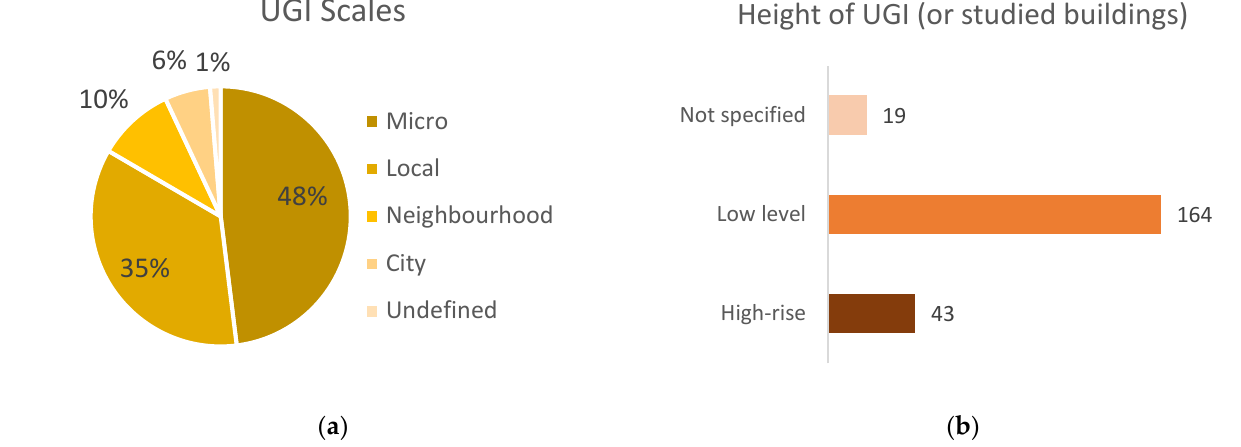
Figure 11. ( a ) The scale of the studied UGI; ( b ) the height of the UGI (or studied buildings). Similar to the scale, the height of the UGI or, otherwise, the height of the studied site Building types represent the scale and function of a building, the occupancy level, also impacts the effectiveness of the UGI. As claimed by Dahanayake and Chow [51], GW provides a higher potential for cooling load reduction when the building height